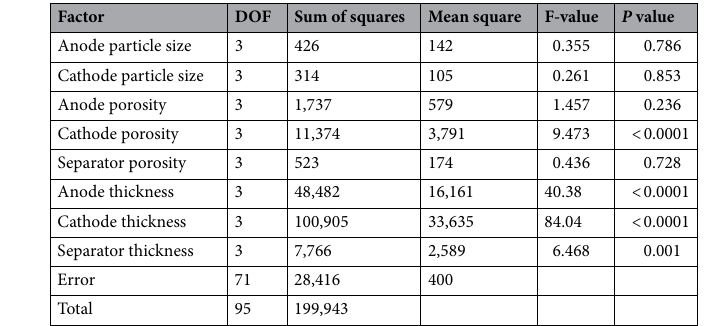
Table 5. ANOVA results of specific power density.